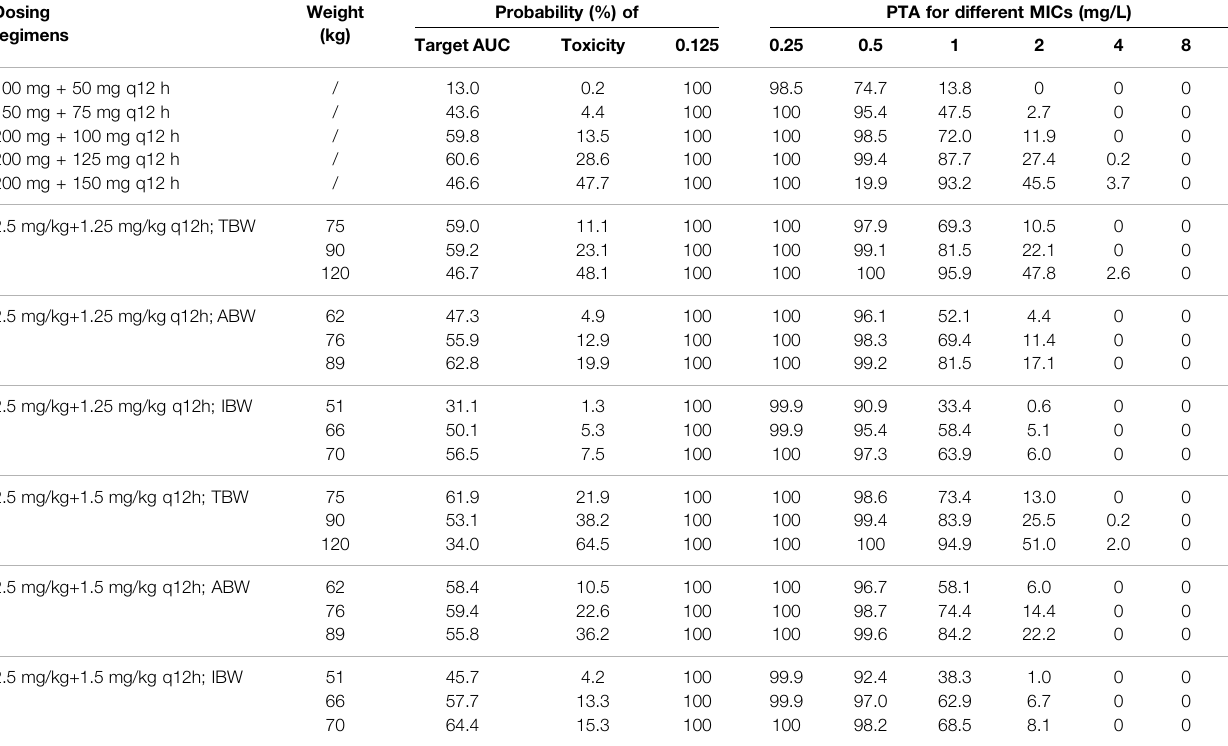
TABLE 3 | Probability (%) of target AUC and toxicity and PTA for different polymyxin B regimens according to the 10th, 50th, and 90th percentiles of TBW, ABW, and IBW. Dosing regimens